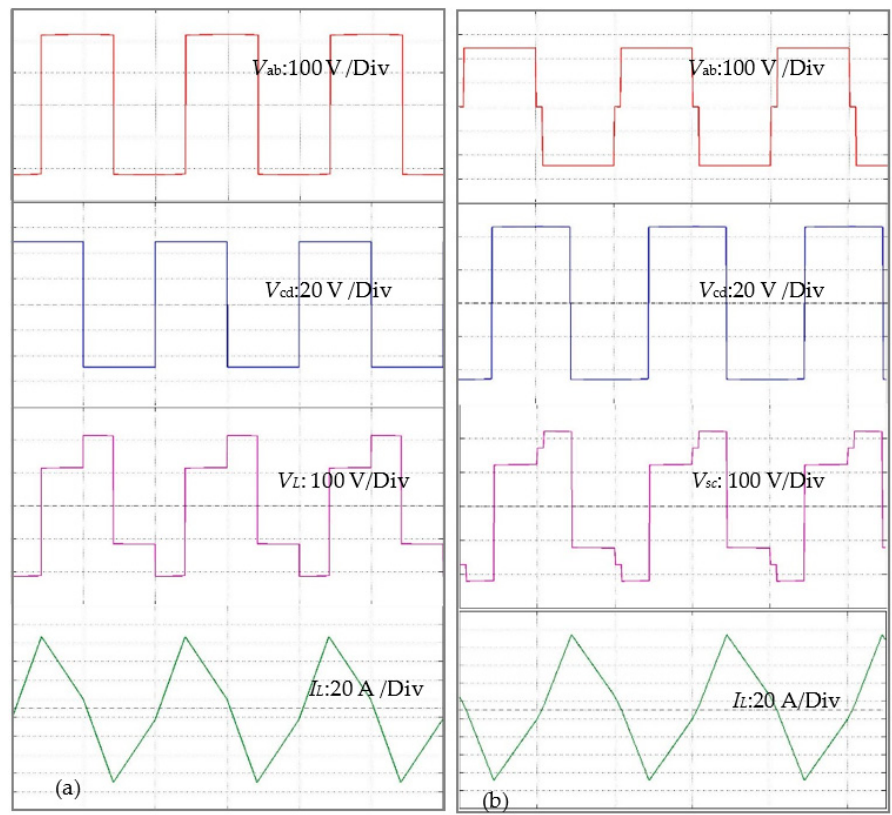
Figure 16. Backward mode operation waveforms of ( a ) SPS control; ( b ) Blended SPS-ESPS control DAB-IBDC. Time scale 10 ms/Div.